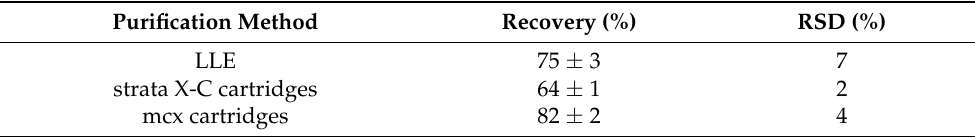
Table 1. Recovery and repeatability of extracted galantamine from Narcissus bulbs using different extraction methods.